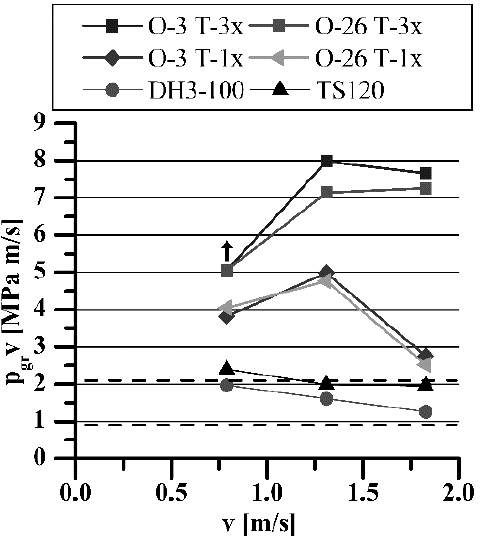
Figure 12. The influence of h-BN on p gr ·v rating of porous sleeves as a function of sliding speed.